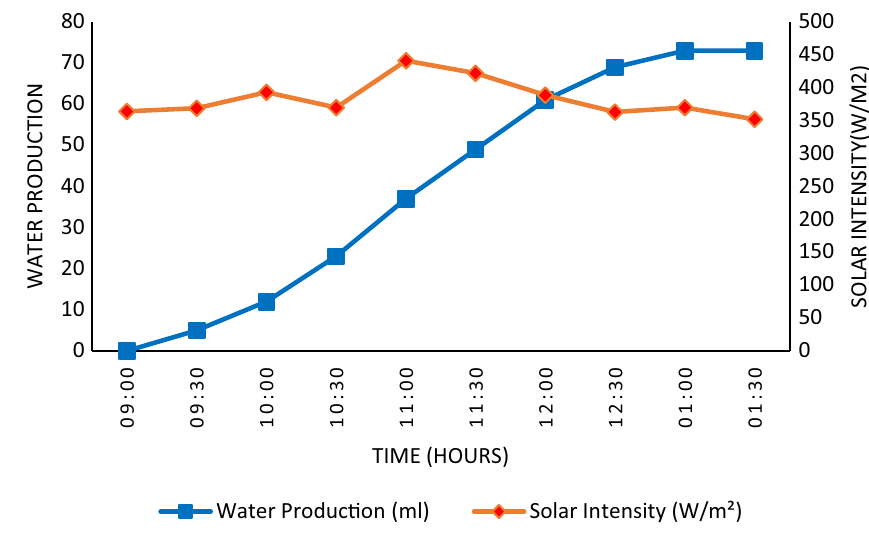
Fig. 8 Variation of water production with solar intensity w.r.t. time for LiBr/River Sand